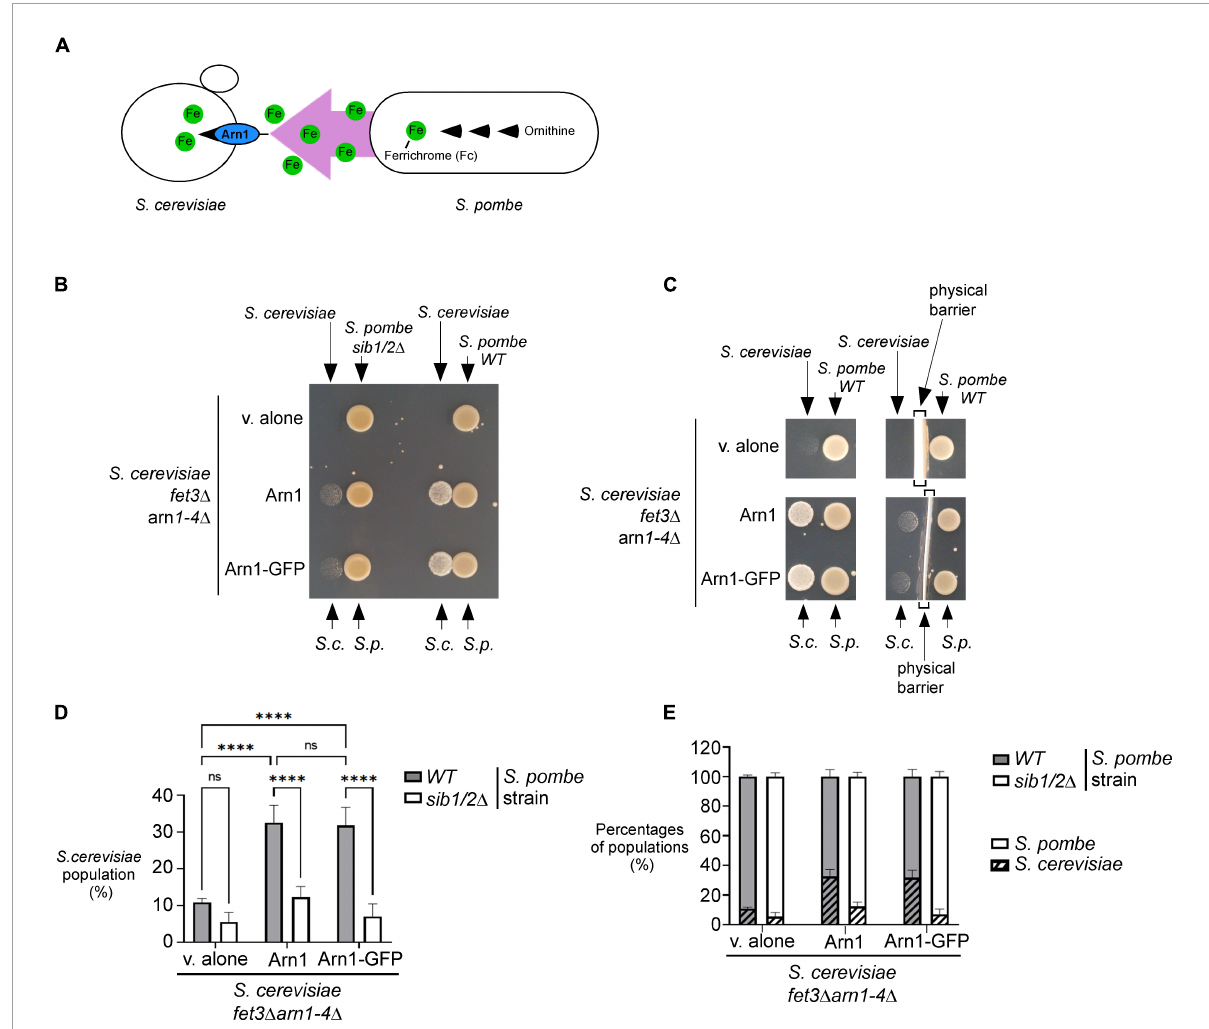
FIGURE2 S. pombe Fc promotes growth of a S. cerevisiae fet3 (cid:49) arn1-4 (cid:49) mutant in which the ARN1 gene is returned. (A) Schematic representation of a S. cerevisiae fet3 (cid:49) arn1-4 (cid:49) mutant expressing ARN1 in co-culture with a S. pombe strain that was competent to synthesize and excrete Fc-iron. (B,C) S. pombe wild-type (WT) and sib1 (cid:49) sib2 (cid:49) strains were grown to an OD 600 of 1.0 in the presence of FeCl 3 (10 µ M), and half of cells (1 × 10 7 cells/10 µ l) were spotted (right side of each pair of spots) onto SD − Cu − Fe medium. S. cerevisiae fet3 (cid:49) arn1-4 (cid:49) cells harboring an empty vector (v. alone) or expressing ARN1 or ARN1-GFP were grown in SD − Cu − Fe to an OD 600 of 1.0. Cells were washed, diluted 10,000-fold, and spotted (3,000 cells/10 µ L) (left side of each pair of spots) onto SD − Cu − Fe medium in the vicinity of the S. pombe strains. In the representative experiment in (C) (right side), a physical barrier was installed between point-inoculated S. cerevisiae and S. pombe strains. S.c., S. cerevisiae ; S.p., S. pombe . (D,E) S. pombe wild-type (WT) and sib1 (cid:49) sib2 (cid:49) strains were mixed with the indicated plasmid-transformed S. cerevisiae fet3 (cid:49) arn1-4 (cid:49) strain in a 1:1 ratio. Each pairwise co-culture was grown in liquid SD − Cu − Fe medium in the presence of Dip (100 µ M) for 18 h. The morphology of yeast cells was examined by Nomarski optics for determining the number of S. cerevisiae cells vs. the total number of fungal cells. Representative results are presented for the percentages of S. cerevisiae cells with the indicated plasmids in co-culture with S. pombe (WT or sib1 (cid:49) sib2 (cid:49) ) (D) . Comparative results of percentages of each population representing S. cerevisiae cells vs. S. pombe cells after they were grown together for 18 h (E) . A minimum of 300 cells were examined for each pairwise co-culture. The results are representative of three independent experiments. The error bars indicate the standard deviation ( ± SD; error bars). The asterisks correspond to p < 0.0001 (****) (two-way ANOVA with Tuckey’s multiple comparisons test against the genotypes of S. pombe and S. cerevisiae strains), whereas ns stands for not